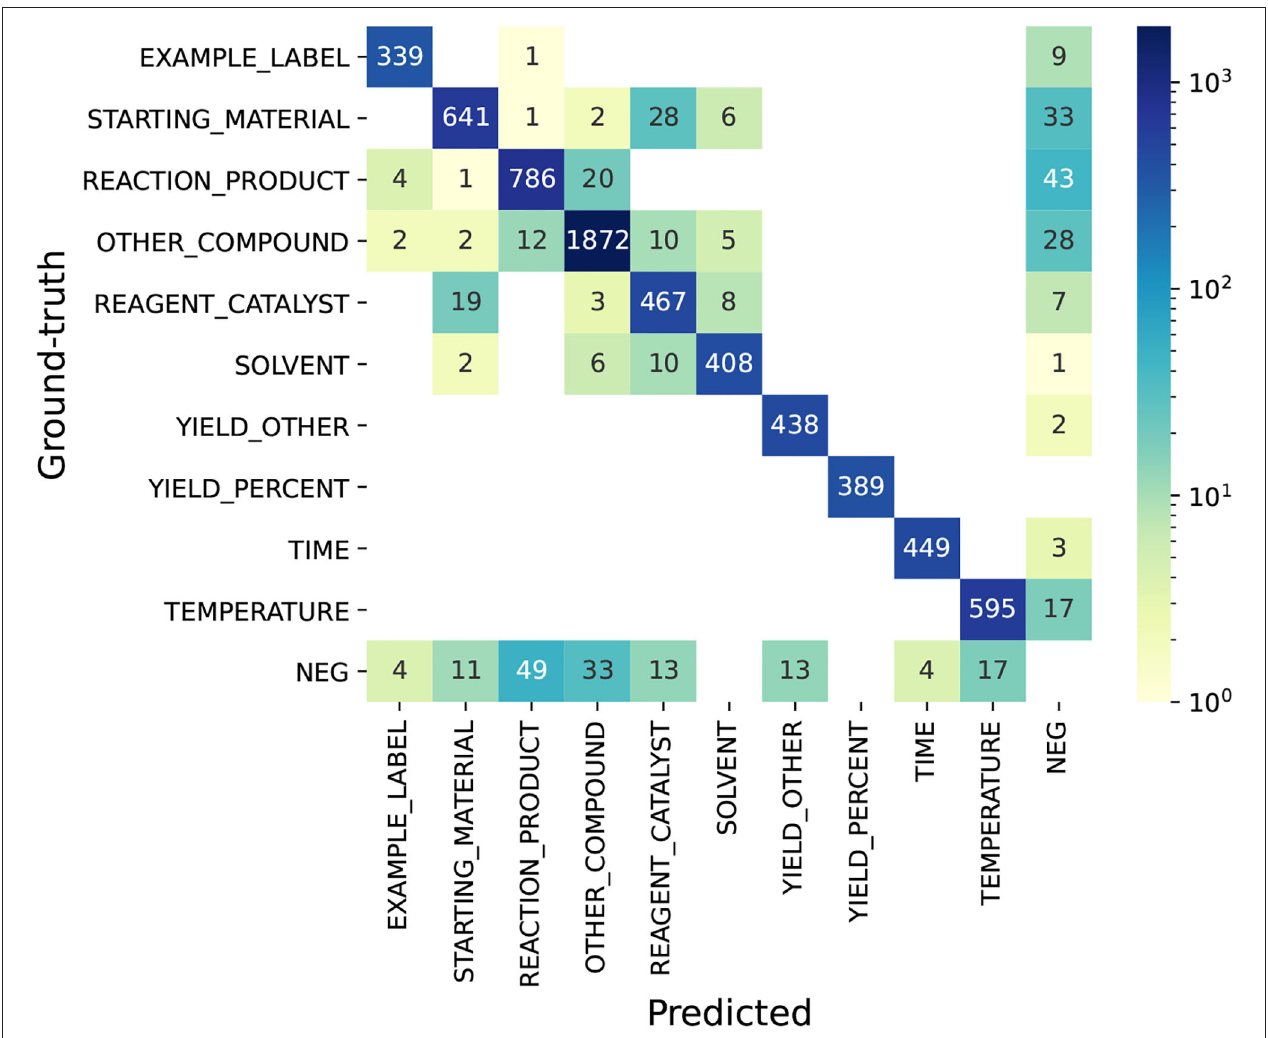
FIGURE 8 | Confusion matrix of the top system on Task 1—NER. NEG (negative entity): ground-truth (or predicted) entities whose text spans are not annotated as entities in the predicted (or ground-truth) set. This confusion matrix is computed under the scenario of exact span-matching.